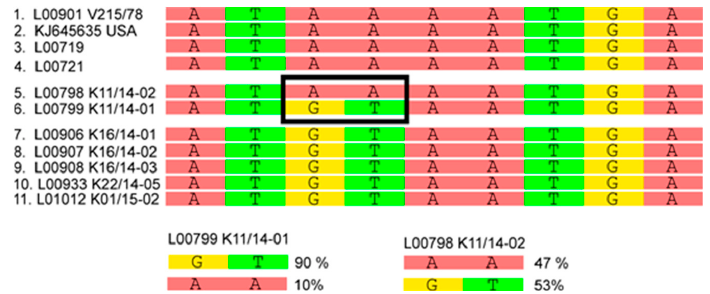
Figure 3. Example of minor variant analysis of two PEDV samples. Boxed nucleotides represent position 27,429-27,430 of strains PEDV/GER/L00798 K11_14-02/2014 and GER/L00799-K11_14- 01/2014. These mixtures imply that the two strains represent the transition between different PEDV. More details on the detected variants are given in Supplementary Table S2.